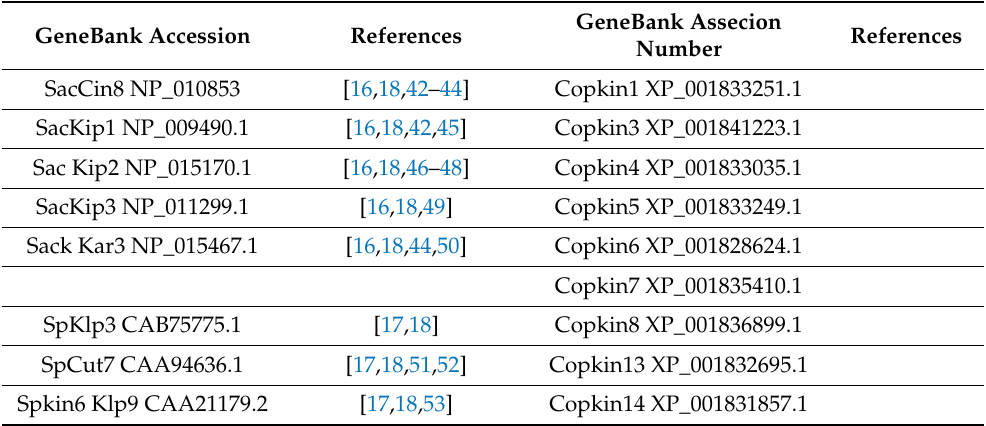
Table 1. The GeneBank Accession or PID and reference numbers of kinesin proteins discussed in the text and presented in the tree based on the alignment of kinesin motor domains (Figure 2).